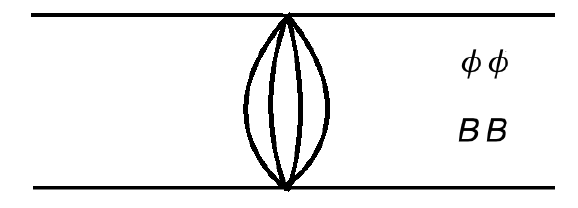
Figure 5 . Propagation of (cid:30)(cid:30) or BB in a ladder